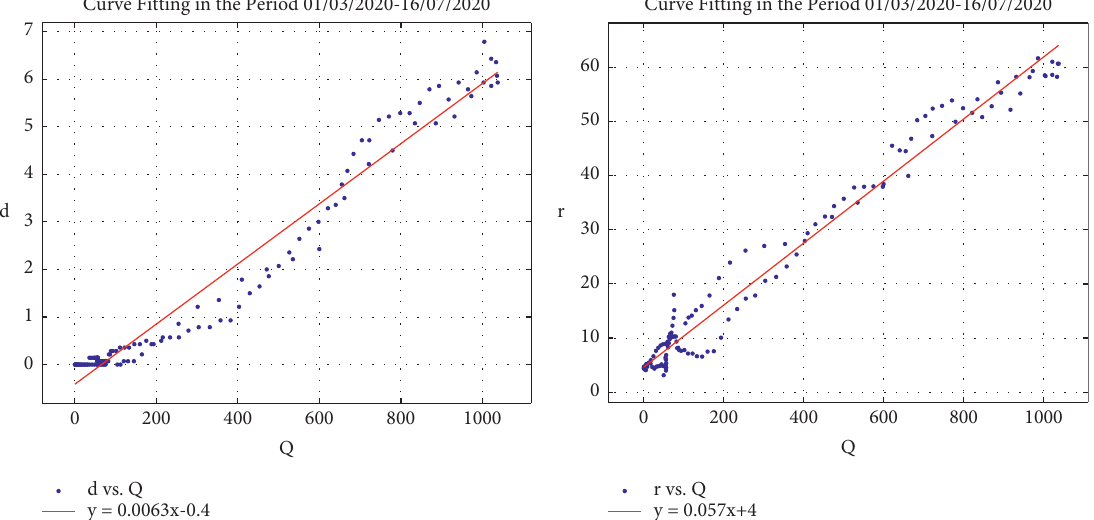
Figure 6: Linear regression in the period from 01/03/2020 to 16/07/2020 to estimate the parameters α